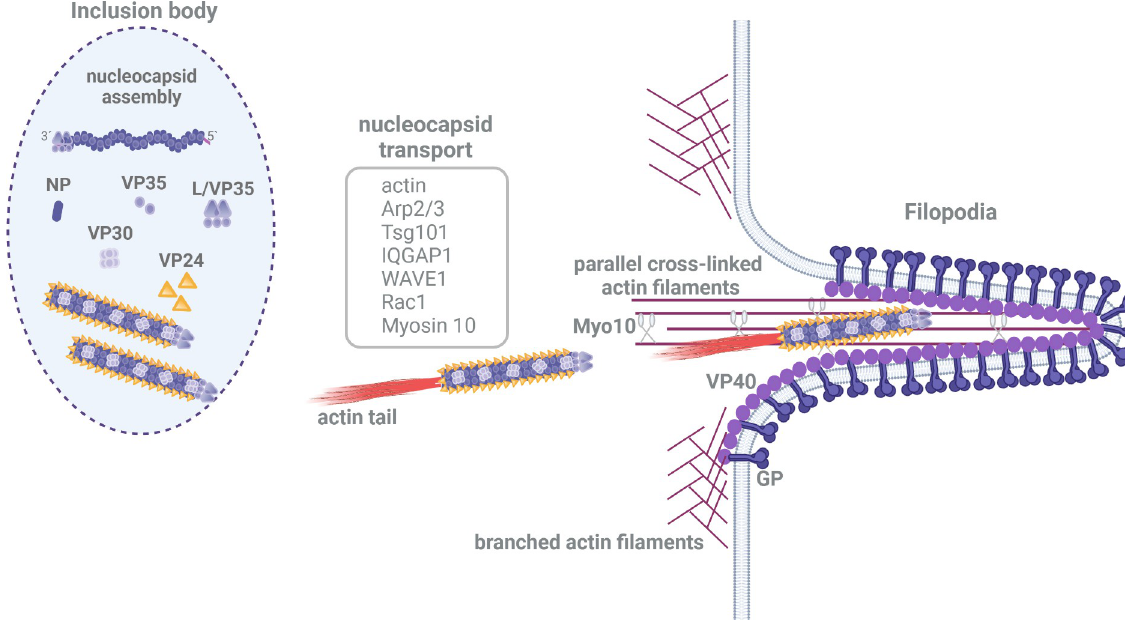
Fig 4. Transport of nucleocapsids from inclusion bodies to budding sites. Transport-competent NCs composed of all the NC proteins are formed inside IBs. The involvement of different host cell factors is required for the actin-dependent transport of NCs (gray box). Outside the IBs, actin tails are formed at one end of the NC in the cytosol, which drive their transport. After reaching the plasma membrane, budding of filoviruses occurs mainly at filopodia, in which myosin 10 may support the transport of NCs along parallel actin filaments. Figure was created with BioRender.com. IB, inclusion body; NC,